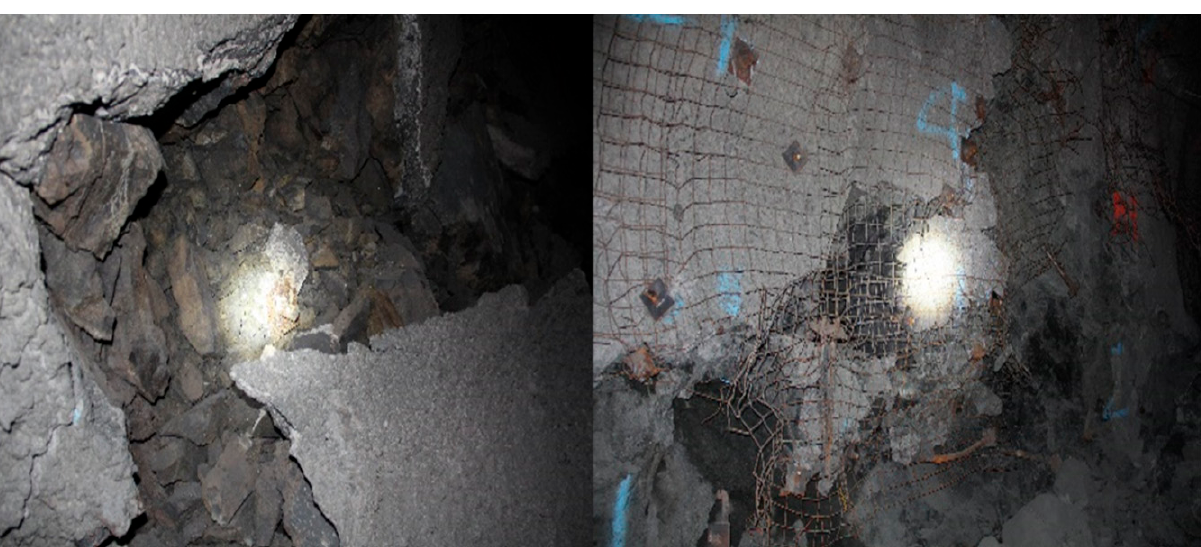
Figure 11. Yield zones in the MP#1 at step S1 and step S83. 6.2. Assessment of the Stope Access Stability among Three-Pillar Recovery Schemes 6.2.1. Tangential Stress Criterion (Ts) For a rockburst to occur, the rock mass must have the ability to store a considerable amount of strain energy which can be released violently at failure, and there must be an environment for stress concentration and energy accumulation [33,52,53]. Here, the tangential stress criterion was used to compare the stability assessment among the three sill pillar recovery schemes, SBS, SS1, and SS2. According to Wang and Park [53], the rockburst tendency can be evaluated using Ts criterion, as presented in Table 5.